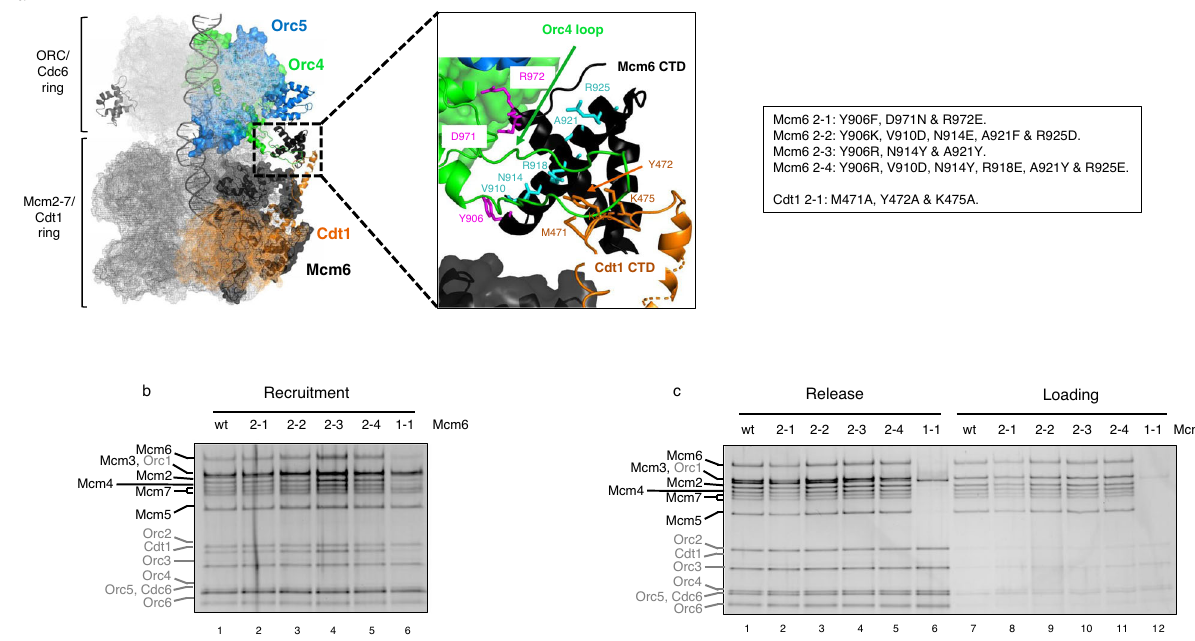
Fig. 5 Interaction with the Orc4 loop by Mcm6 C-WHD is not essential for Cdt1 stabilization of half MCM. a Cryo-EM structure of the OCCM complex 8 . The ORC-Cdc6 ring is illustrated in light grey mesh, while the MCM-Cdt1 ring is in dark grey mesh. The surface of speci fi c individual proteins are highlighted in different colours: Orc 4 (green), Orc5 (blue), Mcm6 (black), and Cdt1 (orange). Of these, the domains studied in this work are further highlighted with their secondary structure, maintaining the colours (extended C-WHD of Cdt1, C-WHD of Mcm6, Orc4 C-WHD and Orc5 AAA lid). Note that the secondary structure of Mcm3 C-WHD is also illustrated in grey. The zoomed area shows in more detail the interaction between the Orc4 loop (shown in green) and the C-WHDs of Mcm6 and Cdt1 (shown in black and orange, respectively). Three different amino acid substitutions, in the C-WHDs of Mcm6 and Cdt1, affecting the interaction with the Orc4 loop were studied. First, contacts at the beginning and the end of the Orc4 loop by the C-WHD of Mcm6 were mutated (Mcm6 2-1, shown in magenta in the zoomed section). Second, different residues present in the main helix of Mcm6 that establish contacts with Orc4 loop were substituted with different amino acids going from mild to severe changes (Mcm6 2-2, 2-3 and 2-4, shown in cyan. See also Supplementary Fig. 5). Third, the contacts between the Orc4 loop and the C-WHD of Cdt1 were mutated in Cdt1 2-1 (in orange). Speci fi c substitutions present in the different proteins mutated are summarized in the box. b Recruitment of MCM-Cdt1, containing Mcm6 wt, 2-1, 2-2, 2-3 and 2-4 mutations (lanes 1-5). Mcm6 1-1 is included as negative control in lane 6. c Release and loading of the complexes analysed in b . The recruitment and loading of the MCM-Cdt1 complex containing Cdt1 2-1 mutation is shown in Supplementary Fig. 6a,